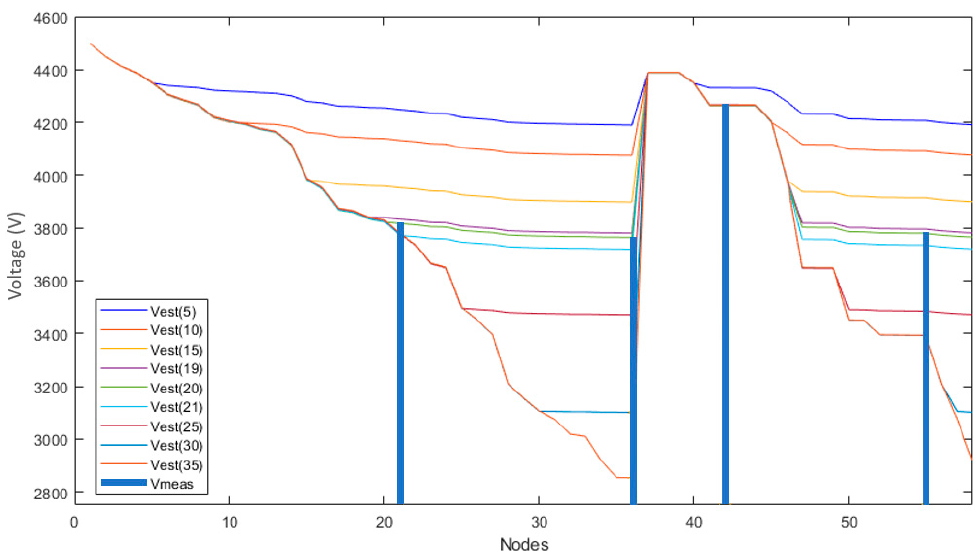
Figure 8. Line-to-ground voltage profiles (phase A ) considering faults applied to different